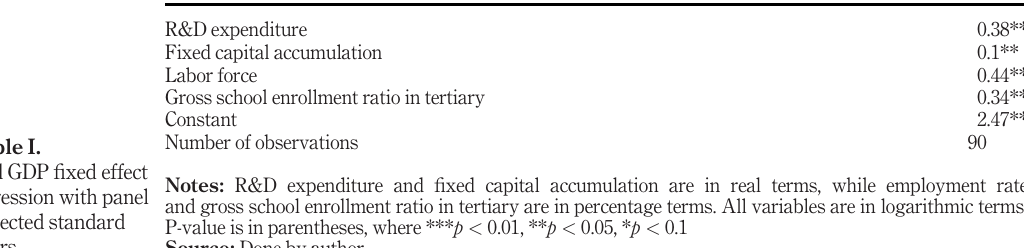
Table I. Real GDP fi xed effect regression with panel corrected standard